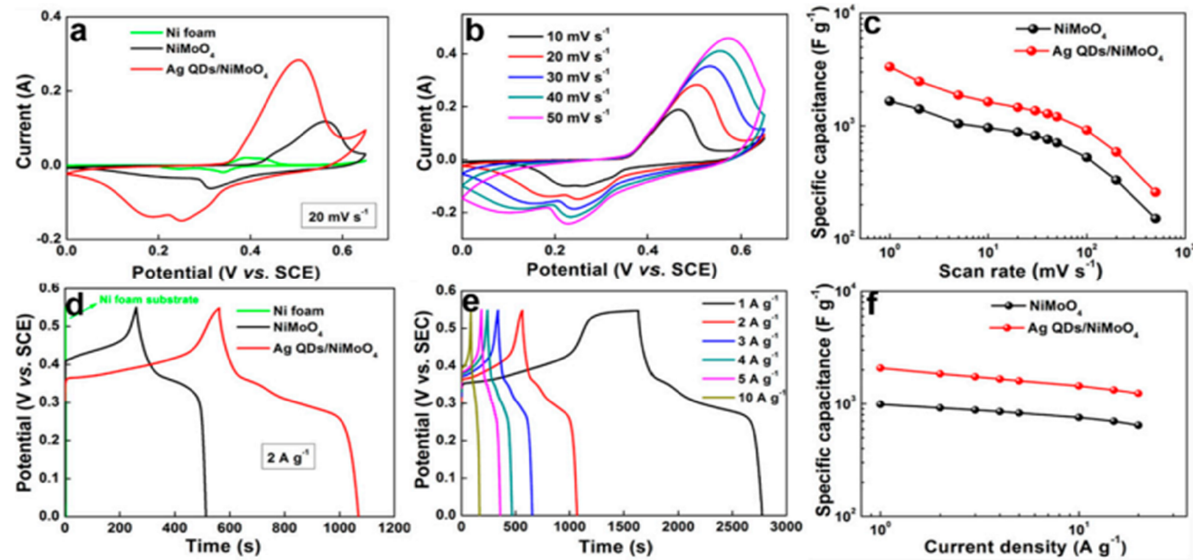
Figure 2. The three-electrode system showing Ag QDs/NiMoO 4 and NiMoO 4 materials CV and GCD measurements ( a ) CV curves at 20 mV/s; ( b ) CV curves of Ag Quantum Dots/NiMoO 4 electrode; ( c ) specific capacitances Vs scan rate meas- urements; ( d ) GCD curves at 2 A/g; ( e ) rate capabilities of electrodes and ( f ) specific capacitances Vs current densities. Reproduced with permission from ref. [78]. Copyright 2020